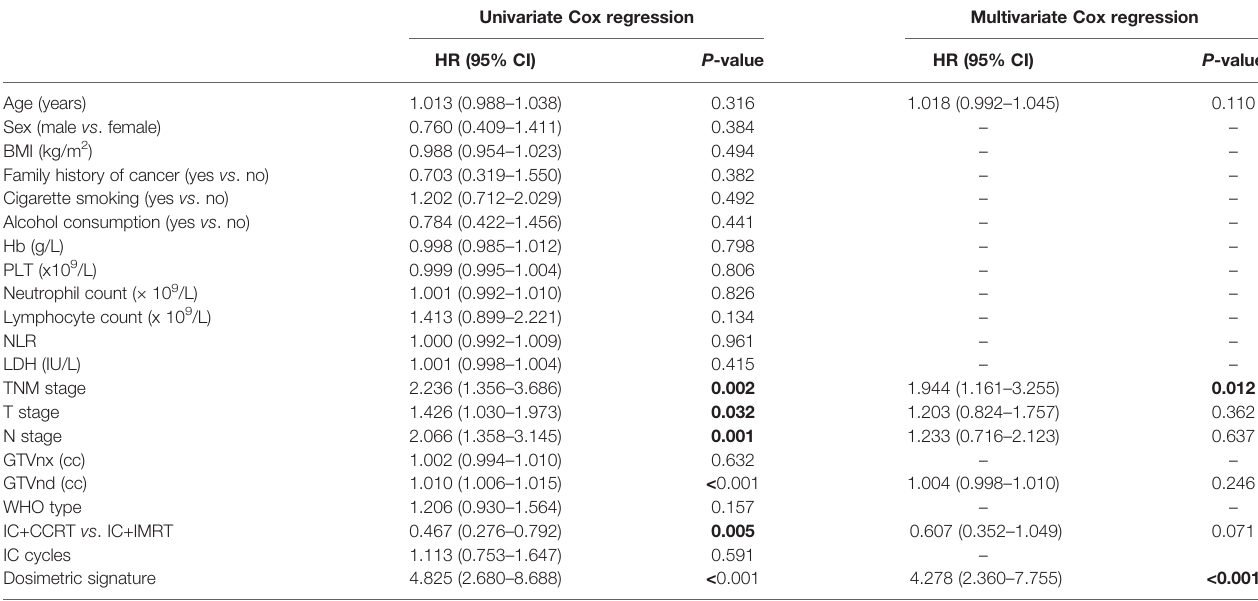
TABLE 2 | Identi fi cation of risk factors of recurrence-free survival by univariate and multivariate analysis in induction chemotherapy ± concurrent chemotherapy cohort.